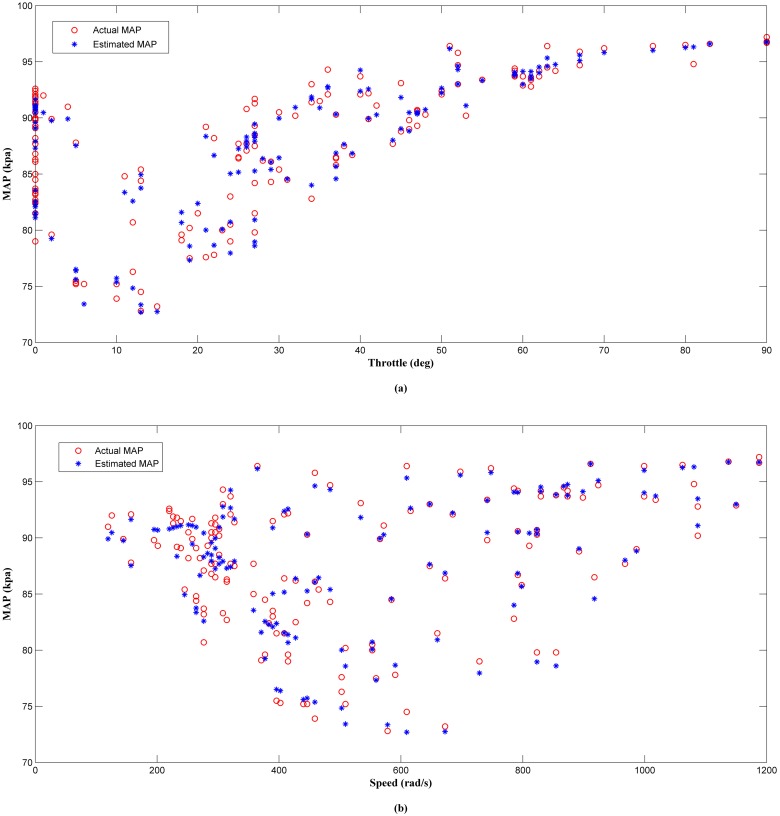
Comparison of the MAP estimator output (LM+BR+PSOa) and actual MAP as function of (a) throttle and (b) speed.